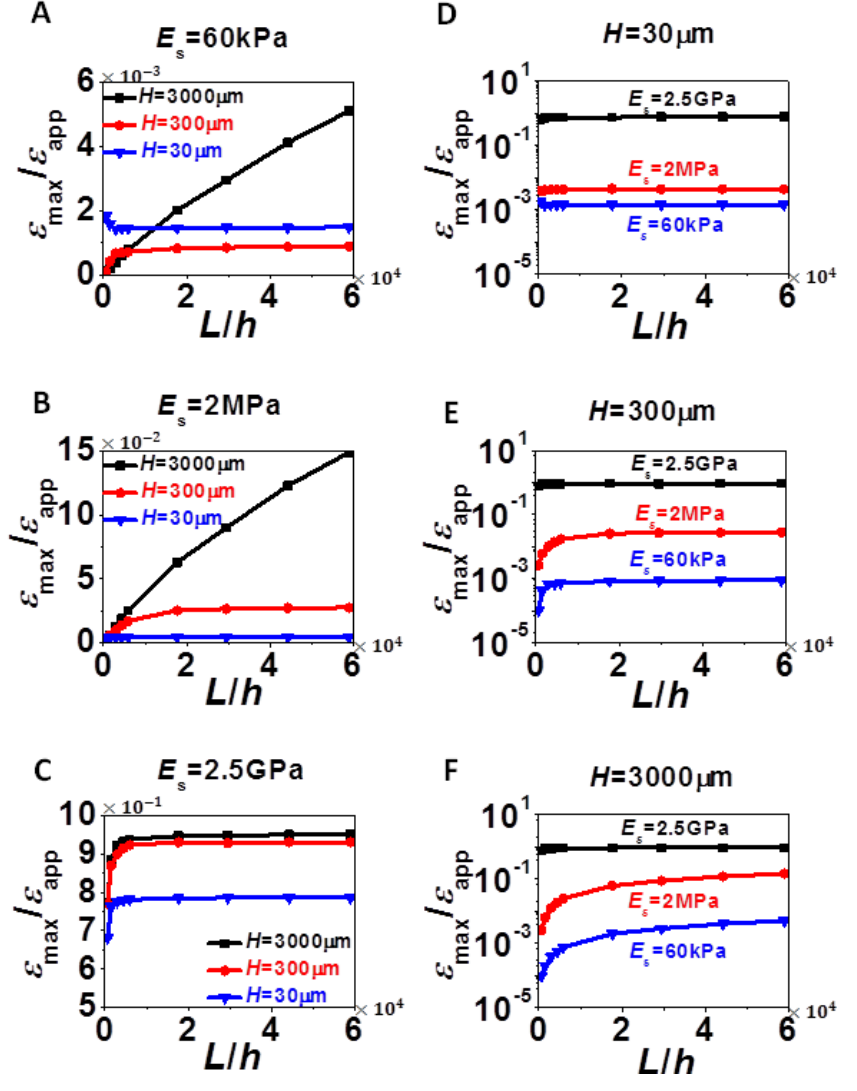
Figure 4. Normalized maximum strains in silicon as a function of normalized silicon length for various combinations of substrate modulus and thickness. ( A ) Ecoflex substrate: E = 60 kPa. ( B ) 10:1 PDMS substrate: E s ( D ) H = 30 μm. ( E ) H = 300 μm. ( F ) H = 3,000 μm. Maximum strain in silicon